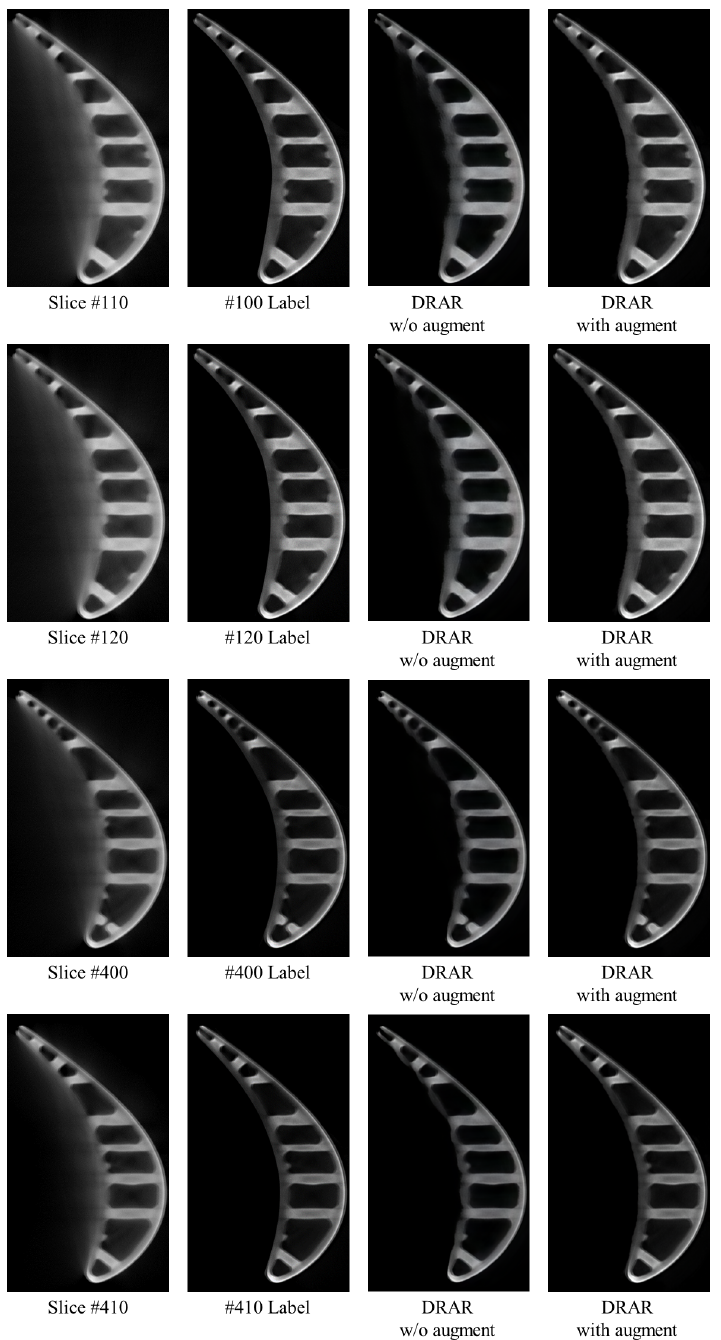
Figure 16. Visual results of DRAR w/o augment and DRAR with augment. Slices #110, #120, #400, and #410 are shown from top to bottom, where the impact of artifacts is more severe in slices #110 and #120, and relatively mild in slices #400 and #410. Enlarged for best